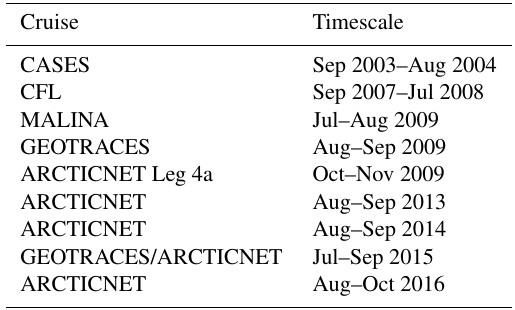
Table 1. Research cruises carried out by the CCGS Amundsen from which the dataset was